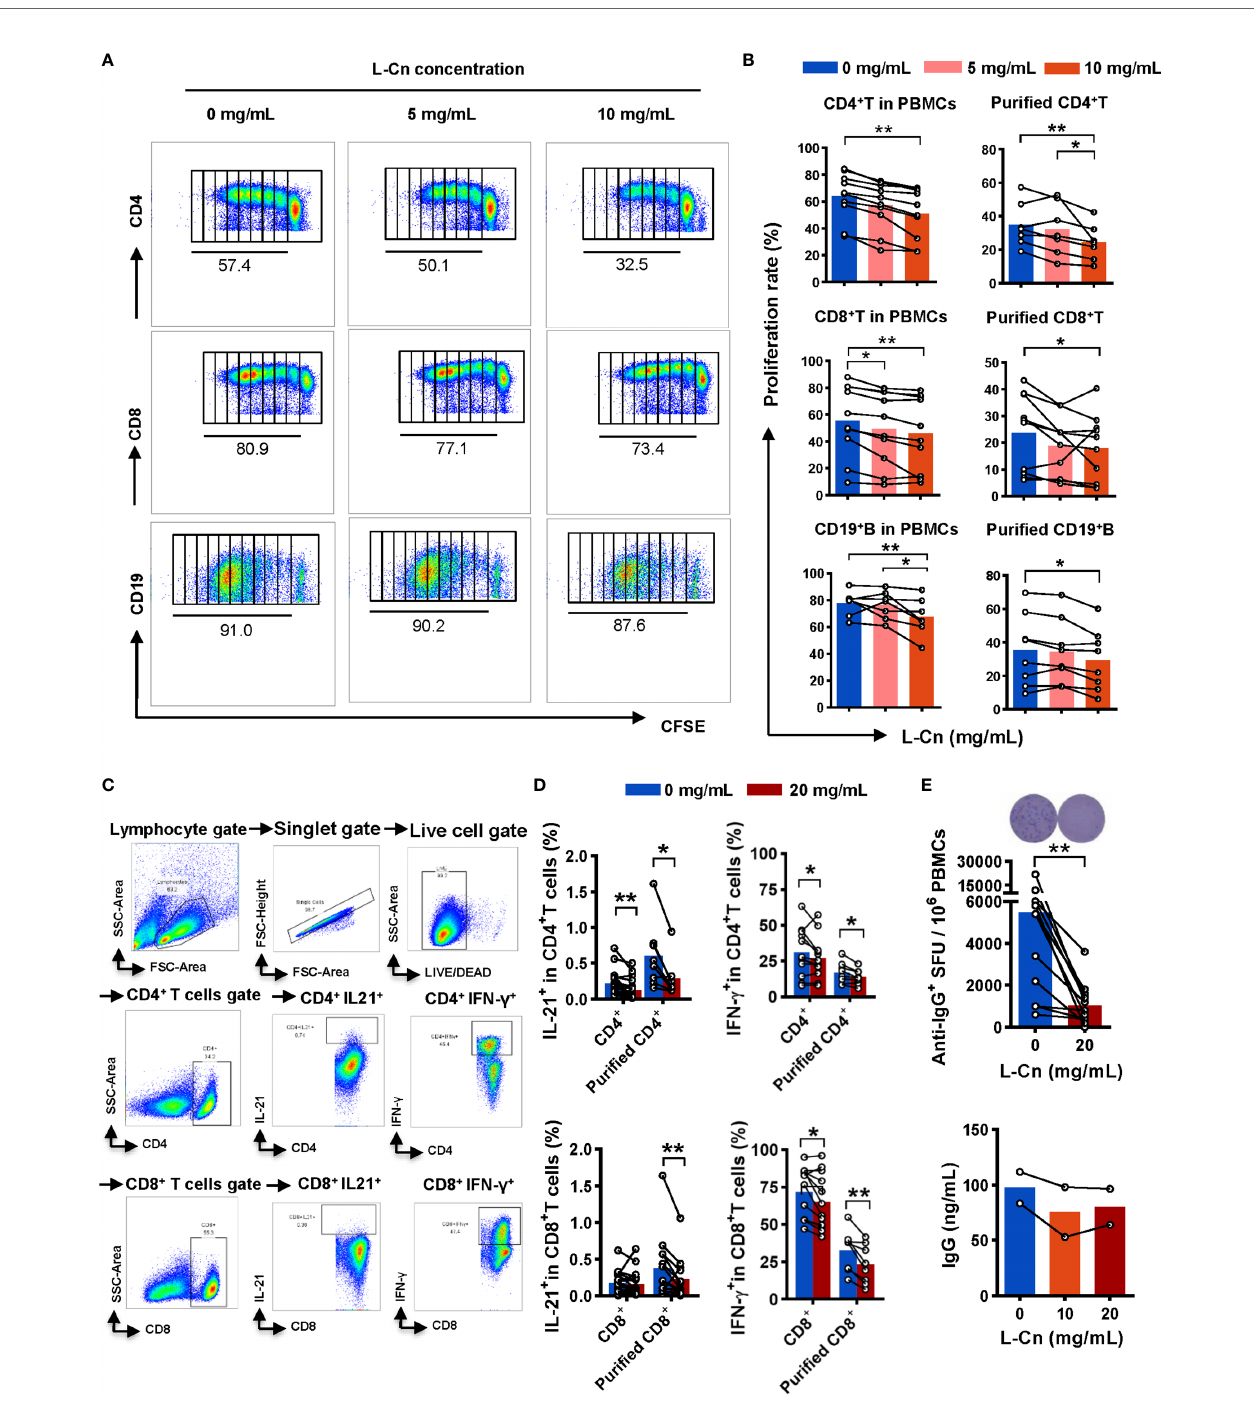
FIGURE 3 | The effect of L-Cn on immune cells. (A, B) The proliferative response of CD4 + T cells, CD8 + T cells, and CD19 + B cells to L-Cn stimulation. Different levels of L-Cn were used to coculture with PBMCs or sorted cell subsets. (C) Gating strategy. (D) IFN- g and IL-21 production of T cells or puri fi ed T cell subsets stimulated with L-Cn (20 mg/mL) in the presence of anti-CD3/28 and PMA/ionomycin. PBMCs or puri fi ed T cells were stimulated with or without L-Cn (20 mg/mL) in the presence of anti-CD3/CD28 (5 µg/mL) for 72 h and restimulated with or without L-Cn for another 6 h in the presence of PMA (50 ng/mL), ionomycin (0.75 µg/ mL), and BFA (1 µg/mL) and subsequently intracellular staining was performed and then was analyzed on a BD FACS-Canto II fl ow cytometer. (E) Detection of IgG- secreting B cells by ELISPOT assay and measurement of IgG concentration in the supernatant by ELISA assay. Image showing the results of representative ELISPOT assay. (B) Friedman test and Dunn ’ s multiple comparisons test. (D, E) Wilcoxon signed-rank test. * P < 0.05, ** P < 0.01. IgG, Immunoglobulin G; L-Cn, L-carnitine; SFU, spot-forming